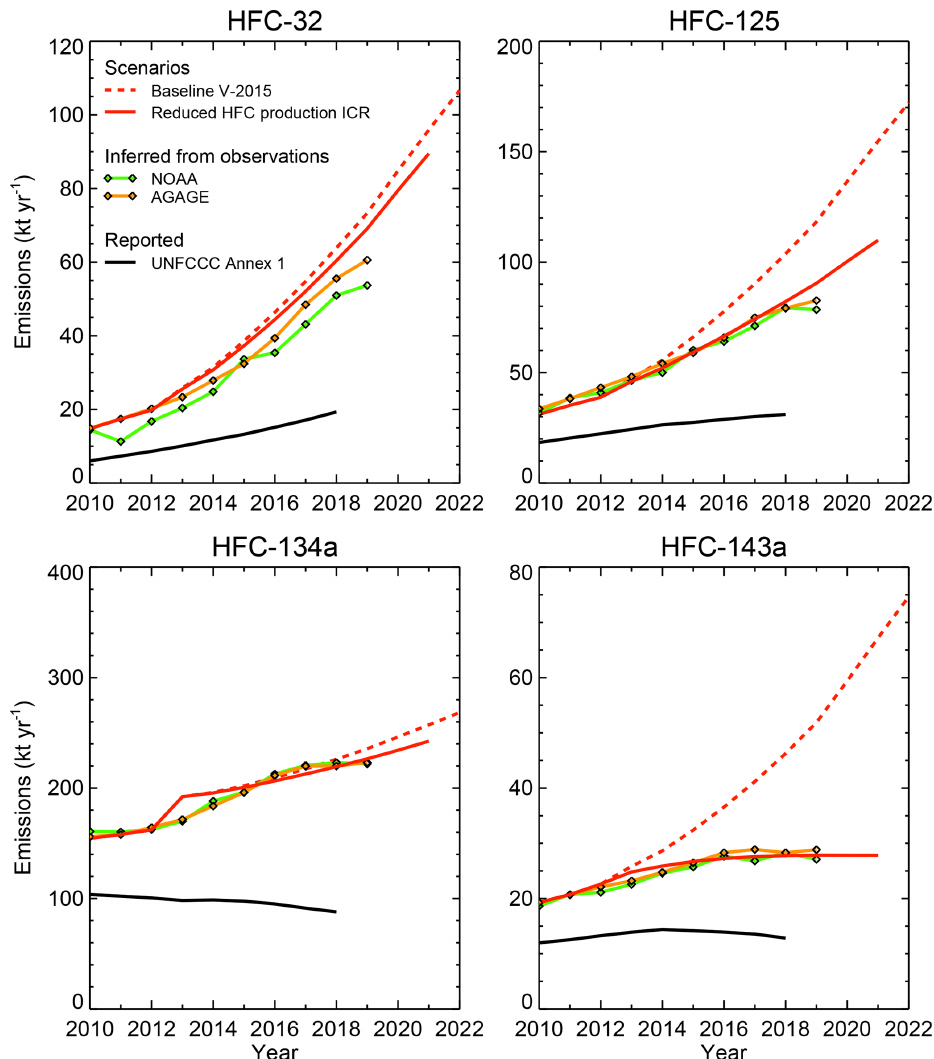
Figure 2. Global total HFC emissions (ktyr − 1 ) from the V-2015 baseline compared with emissions inferred from observed mixing ratios from the AGAGE and NOAA networks. The solid line shows an adjusted scenario with reduced HFC production for industrial and com- mercial refrigeration (ICR) from 2013 onward. Also shown are the emissions reported to the UNFCCC by Annex 1 countries. The scenarios were constrained by the emissions inferred from observed mixing ratios up to